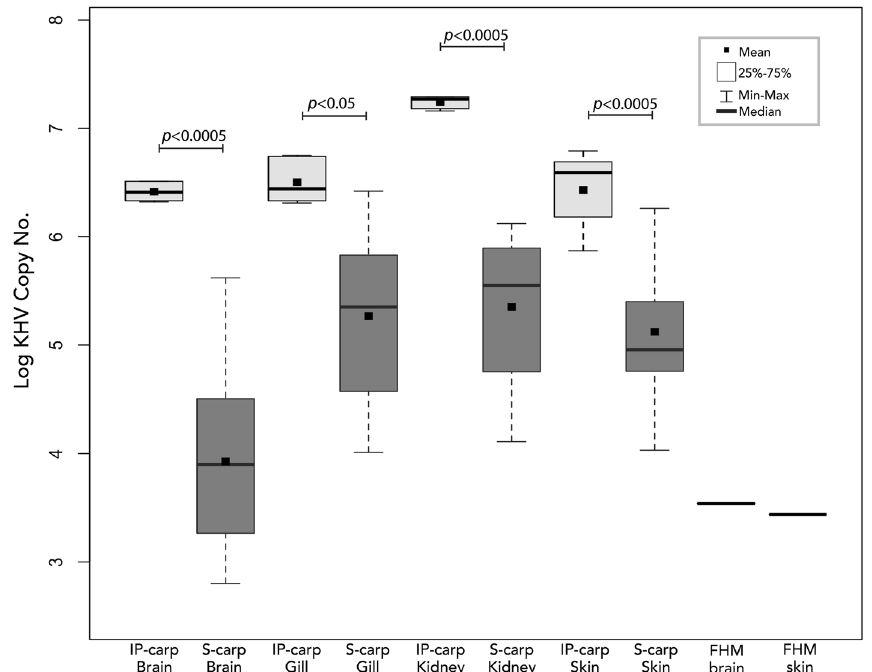
Figure 6. Boxplots of CyHV-3 log copy numbers/mL of tissue supernatant of IP injected carp (IP-carp, light grey boxes), cohabitated sentinel carp (S-carp, dark grey boxes), and in tissues of a single fathead minnow (FHM), quantified using CyHV-3-specific qPCR. No boxes are displayed for FHM tissues since only a single individual tested positive for CyHV-3.